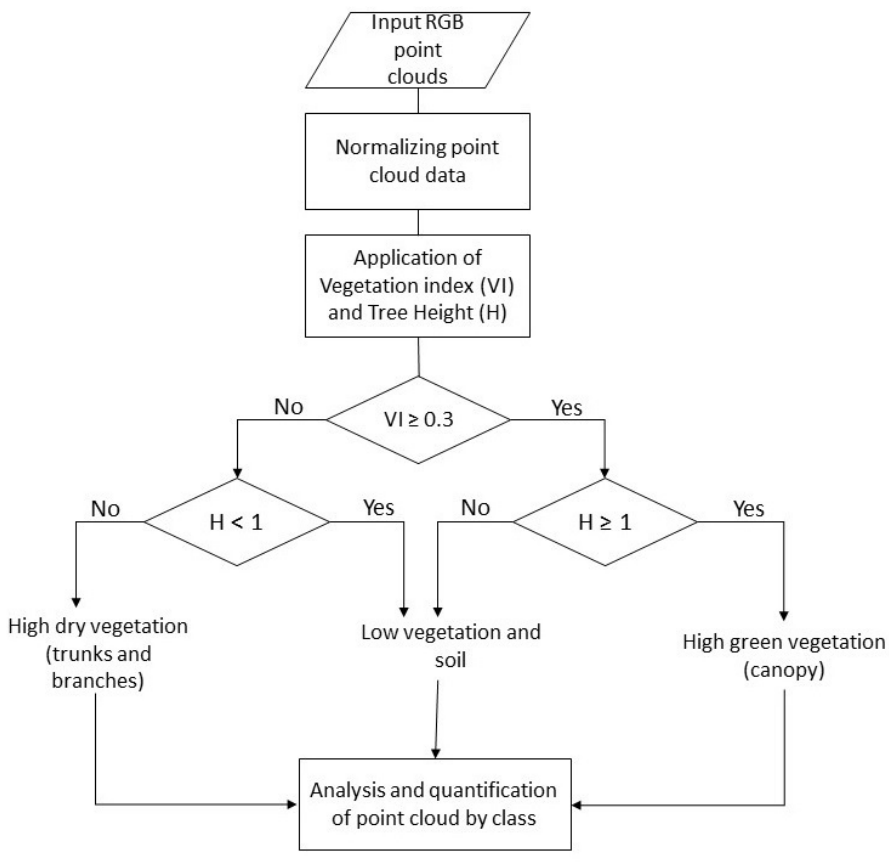
Figure 4. Flow diagram of the method proposed for the fractioning of the point cloud per classes.